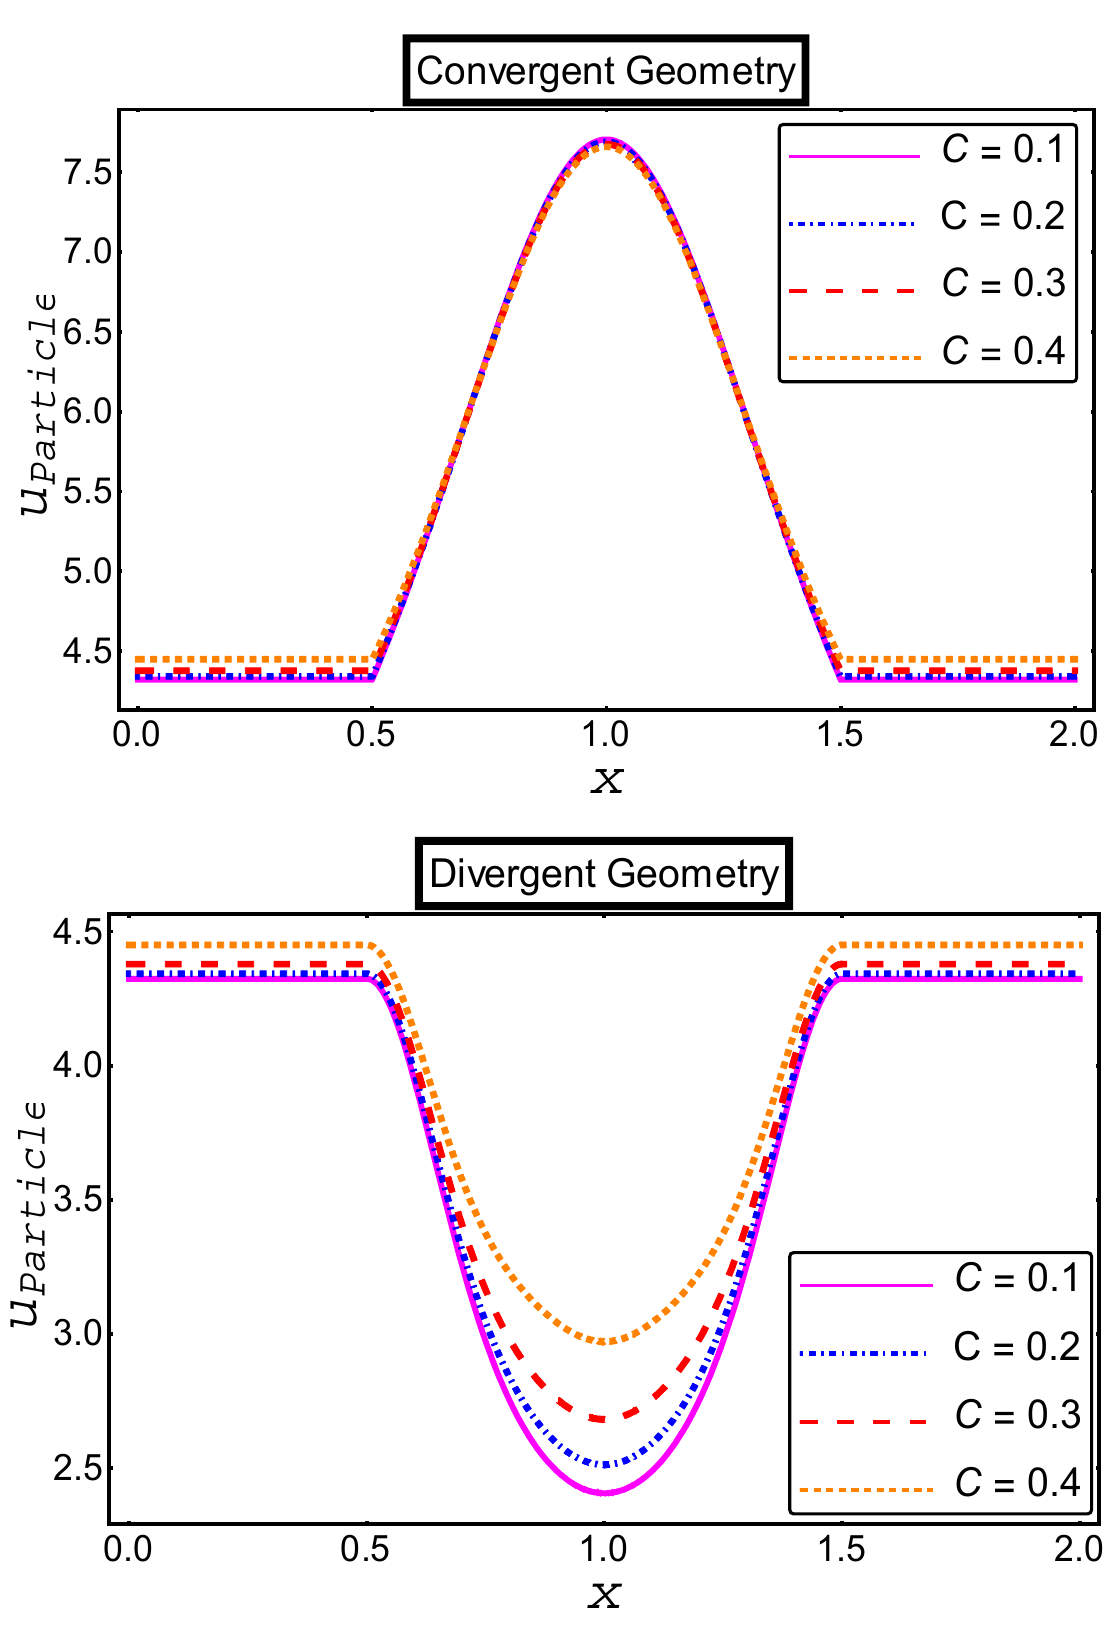
Figure 8. Impact of particle concentration on particle velocity.